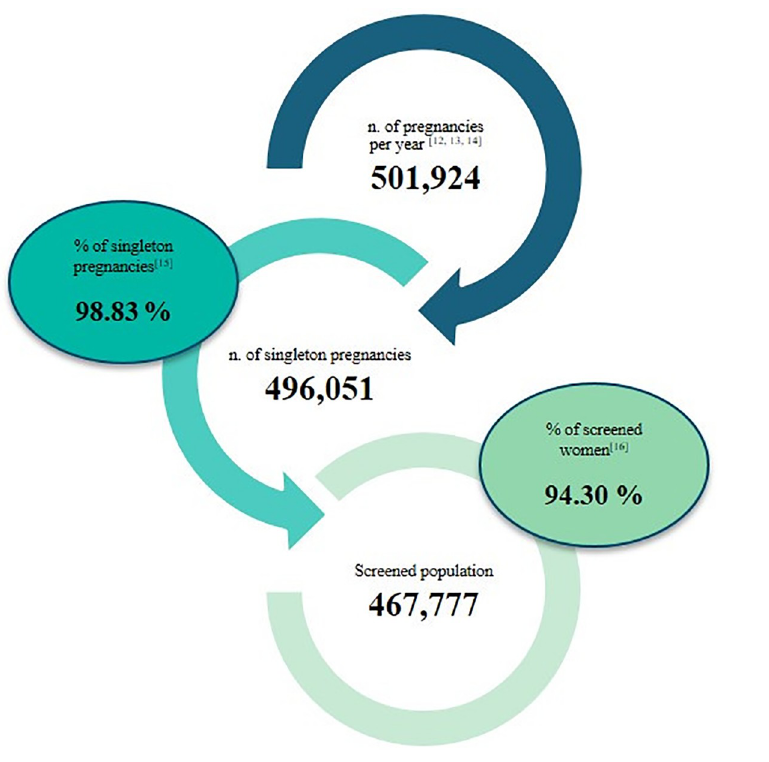
Fig 3. Population